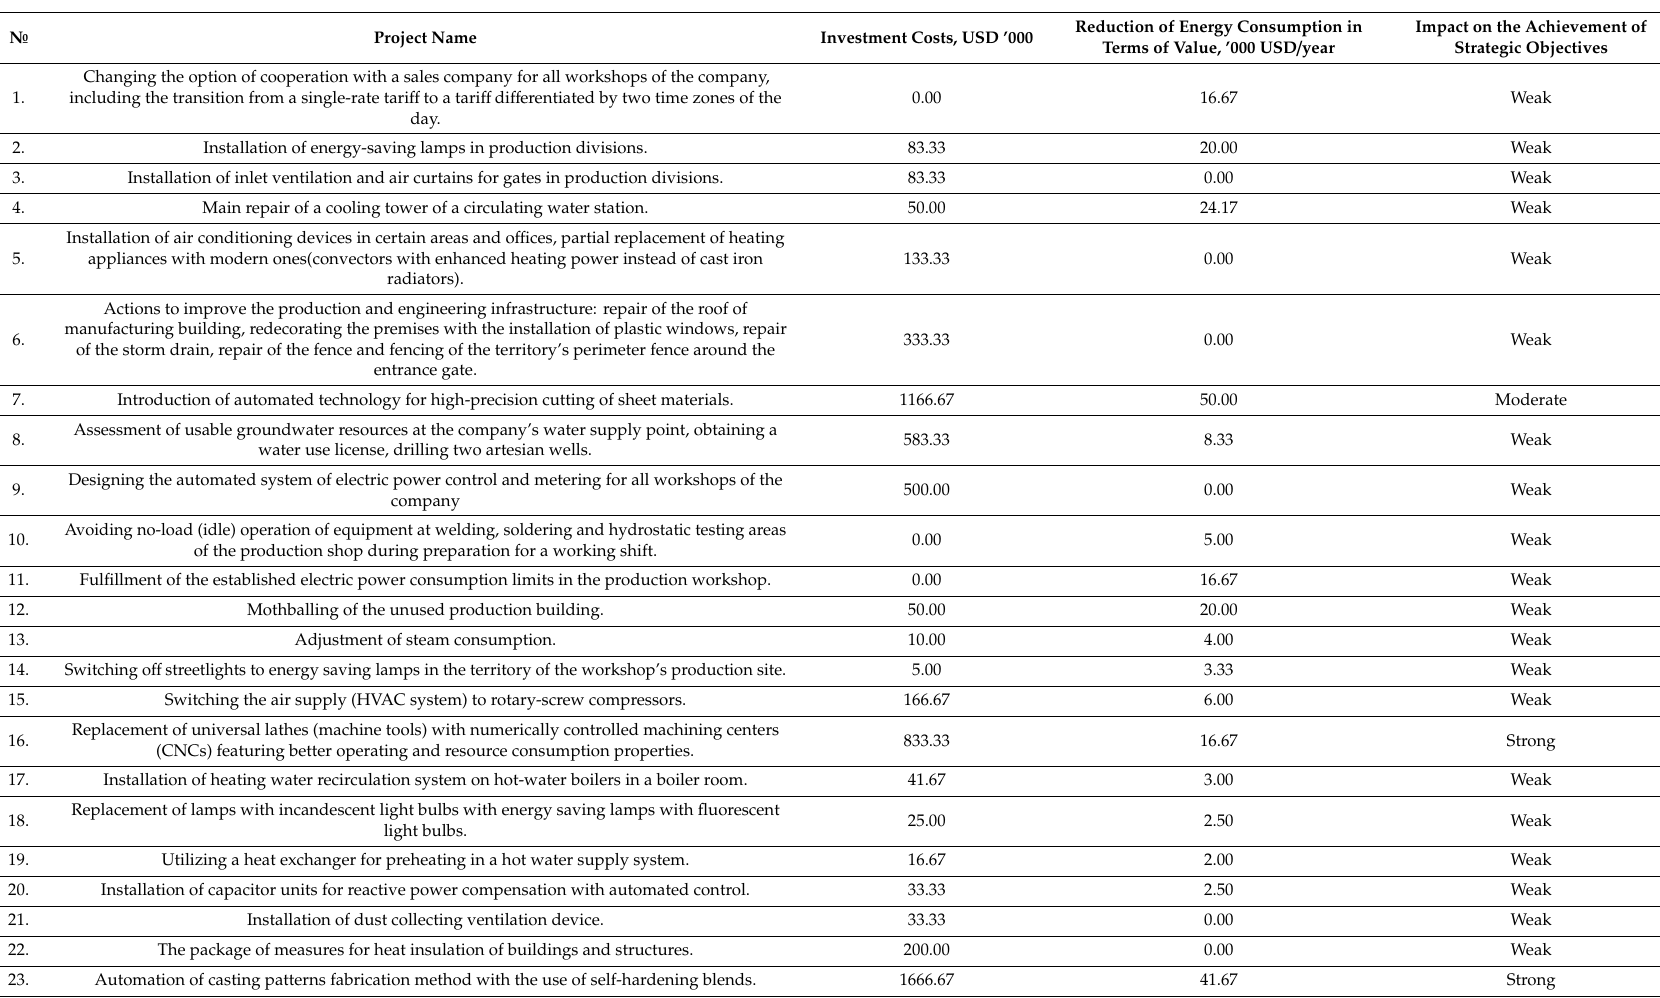
Table 2. A consolidated list of suggestions received to be included in the company’s Energy Saving and Energy E ffi ciency Improvement program (source: compiled by the authors based on the company